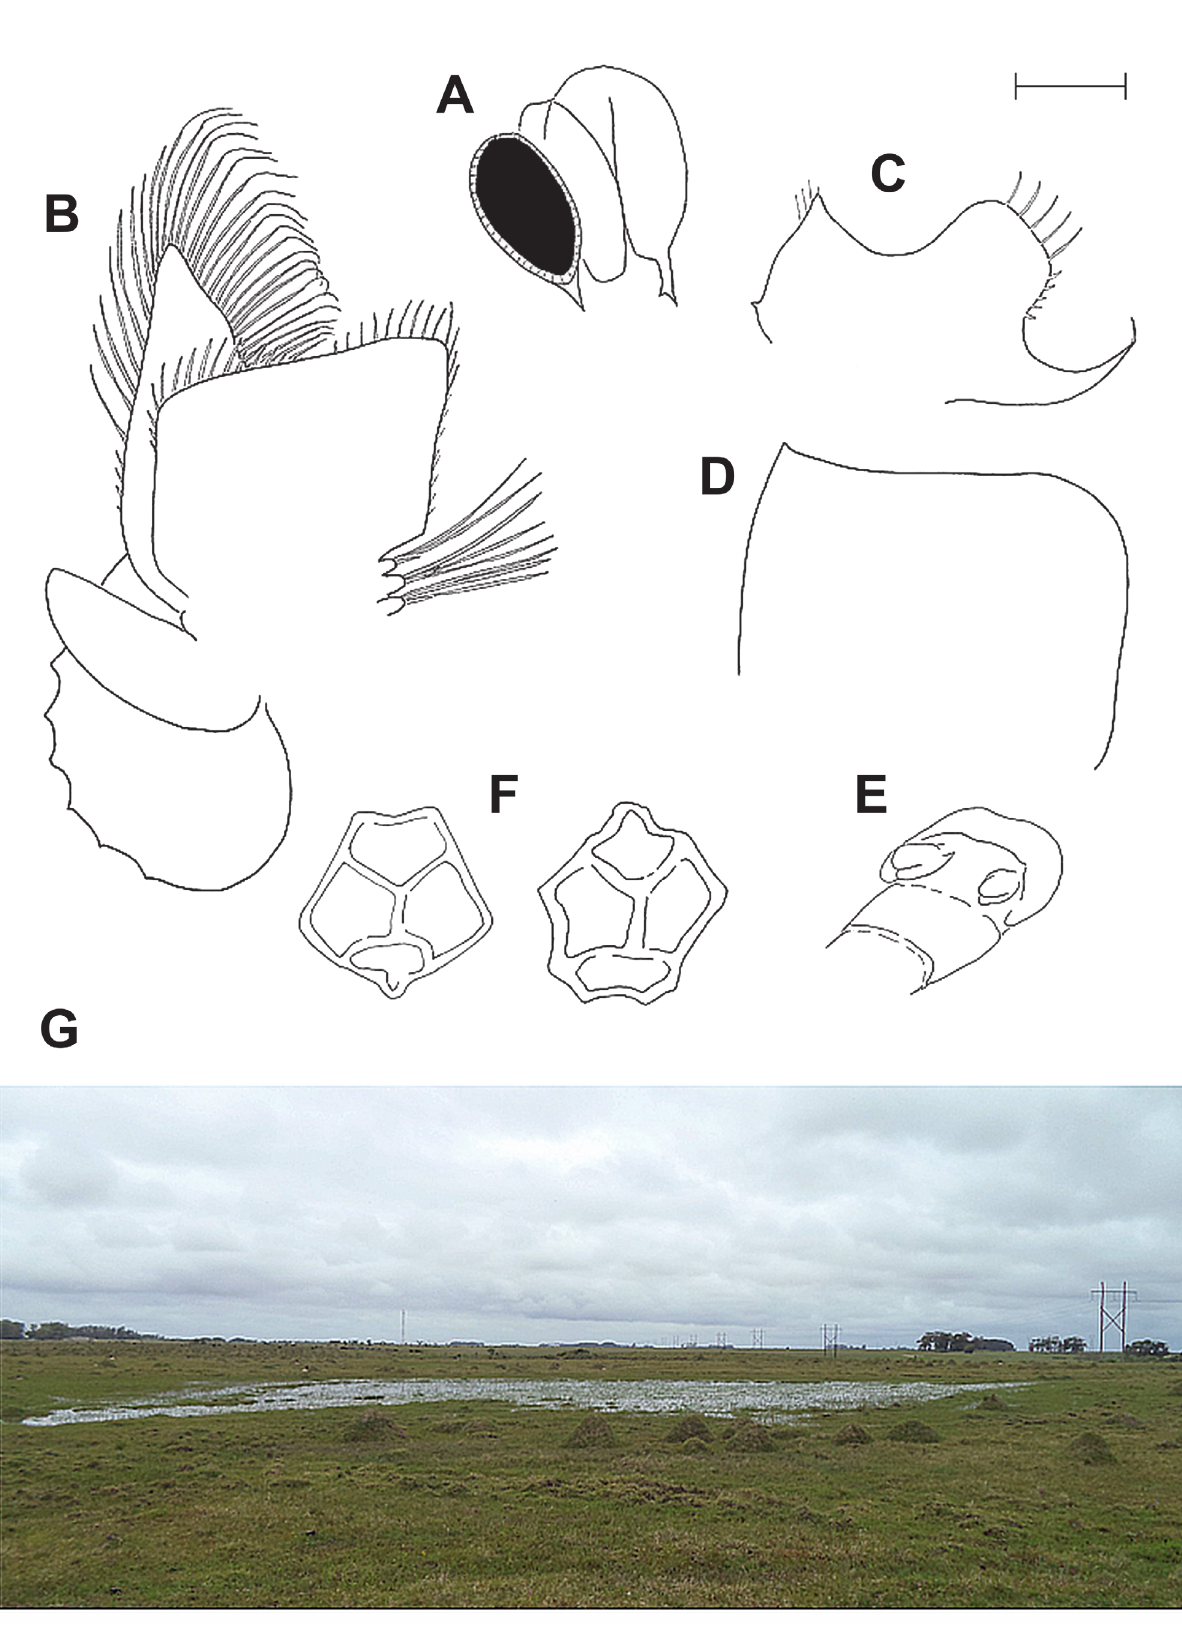
Figure 2. Dendrocephalus riograndensis n. sp., male holotype (MCP 3144): A) Left eye, mandible, and maxillary gland, lateral view. B) Right thoracopod V, anterior view. C) Right thoracopod I endopodite, anterior view. D) Right thoracopod II endopodite, anterior view (spines and setae not shown). E) Genital segments, posterolateral view. F) Eggs. G) View of the type locality, temporary pool close to Mirim Lagoon, Santa Vitória do Palmar, Rio Grande do Sul, Brazil. Scale bar: A–D, 2 mm; E, 3 mm; F, 200